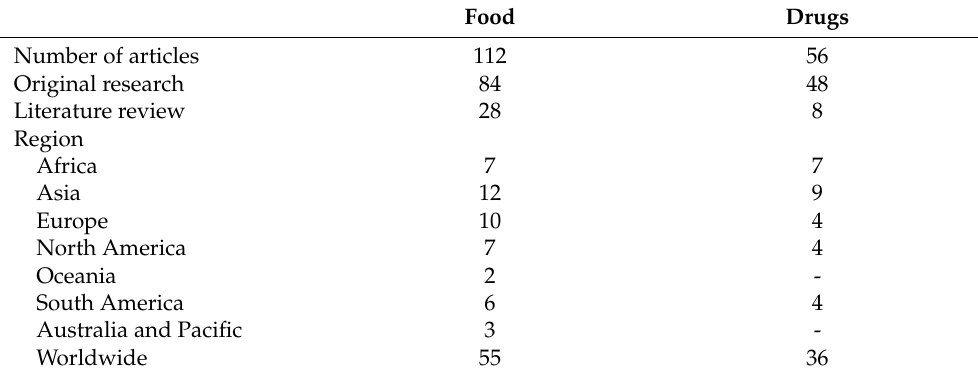
Table 3 details the number of articles and topics studied for food quality and drug safety and region of the study. Table 3. Number of articles and topics studied for food and for drugs, region, and keywords.